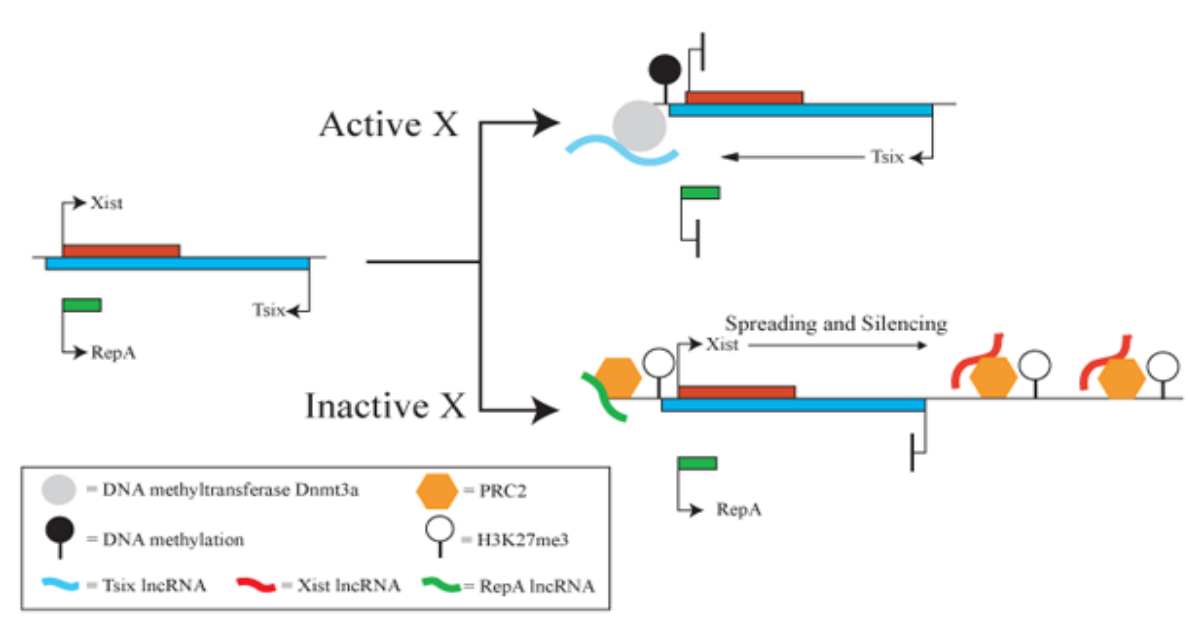
FIGURE 1. The role of lncRNAs in X chromosome inactivation. In the inactive X, the lncRNA RepA is transcribed and appears to recruit PRC2 to the 5’ end of Xist , leading to the seeding of a H3K27 trimethylation heterochromatin patch. This permits production of the Xist transcript, which recruits PRC2 to various sites across the X chromosome in cis and mediates epigenetic silencing. In the active X, the lncRNA Tsix is produced, which may interfere with the function of RepA and prevents transcription of Xist, possibly by recruiting the DNA methyltransferase Dnmt3a to the Xist promoter region. Silencing of Xist by Tsix prevents heterochromatinization and allows one X chromosome to remain